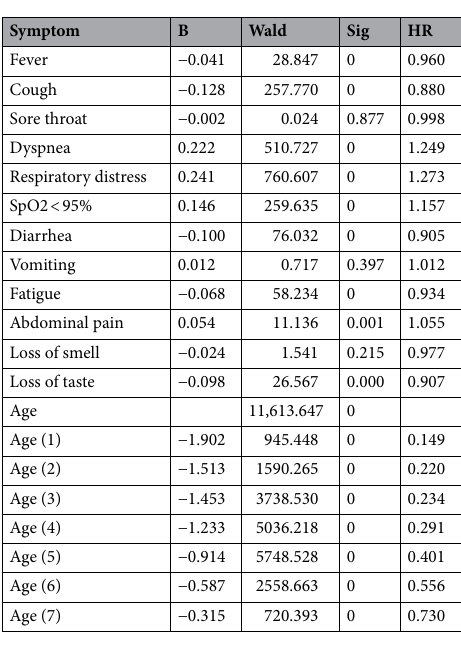
Table 2. Cox regression analysis (hospitalization time).